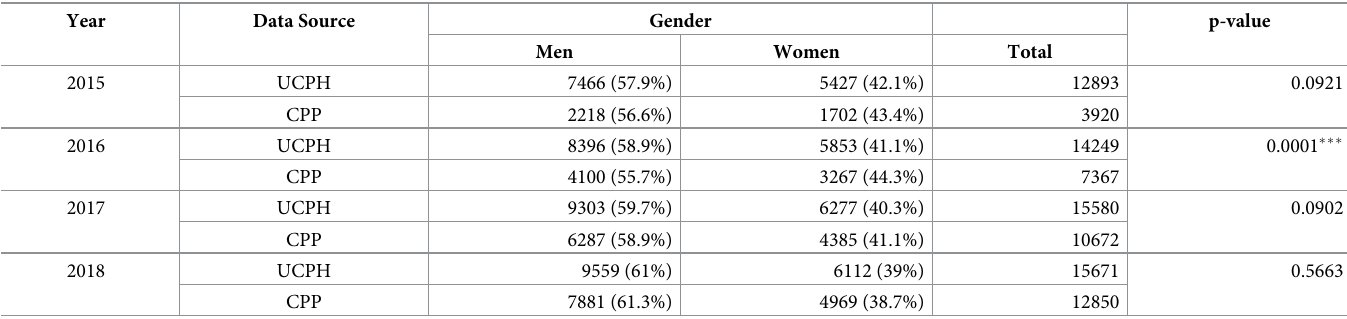
Table 5. Comparison of UCPH and CPP data by year and